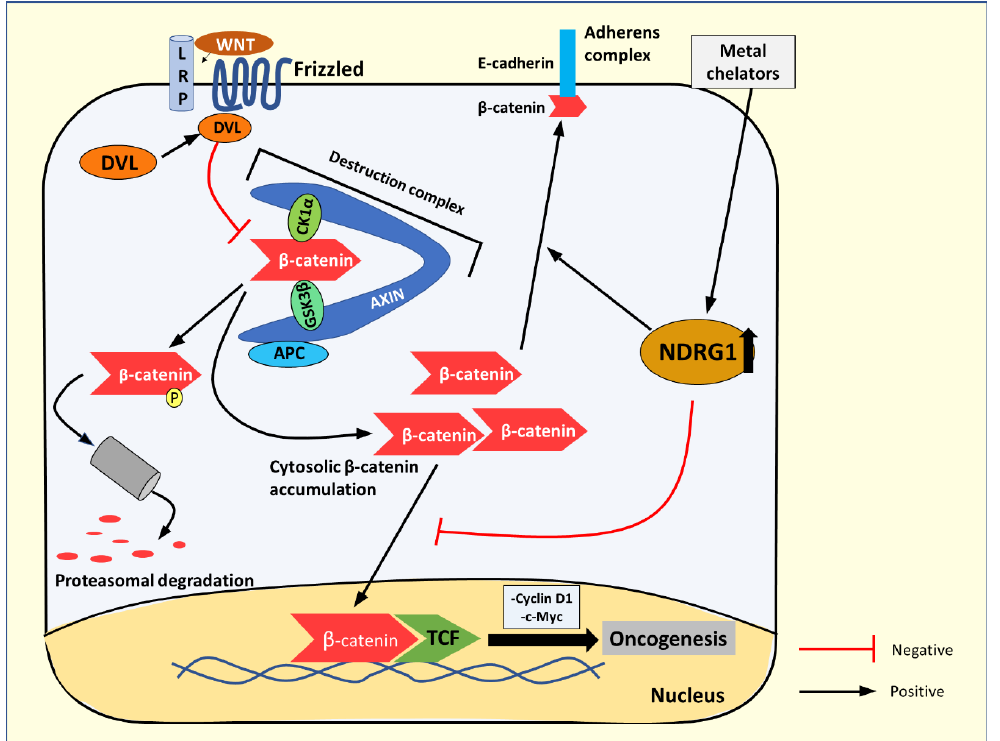
Figure 10. The Wnt/β -catenin signaling pathway and NDRG1 ’s effect on β -catenin localization. In the absence of the Wnt ligand, β - catenin is phosphorylated by the destruction complex (consisting of casein kinase 1α (CK1α), glycogen synthase kinase 3β (GSK3β), the tumor suppressor APC , scaffold protein AXIN, and others (not shown)) leading to its proteasomal degradation. The Wnt ligand binds to and activates the LRP5/6 and Frizzled co-receptors. The activated receptor then recruits Dishevelled (DVL), where it activates and then sequesters the “destruction complex” , which inhibits its activity, allowing non- phosphorylated β - catenin to accumulate in the cytosol and then translocate to the nucleus. Here β -catenin acts as a co-activator with the T cell factor (TCF) family of transcription factors, which up-regulate proteins such as cyclin D1 and c-myc that promote oncogenesis. NDRG1 up-regulation by iron-binding ligands such as DFO or Dp44mT inhibits β -catenin from translocating to the nucleus, preventing its transactivation activity and promoting cyt osolic β -catenin lo- calization to the membrane to form part of the adherens complex.